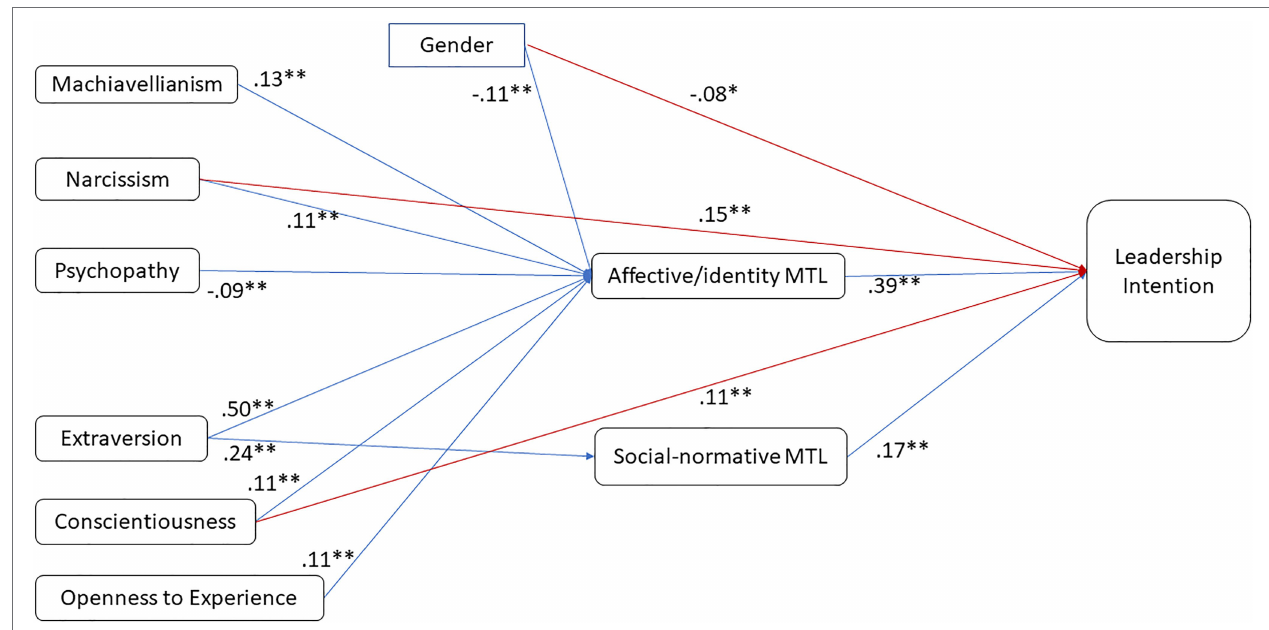
FIGURE 1 | Mediation model showing significant direct and indirect paths. * p < 0.05; ** p < 0.001. Only direct paths or paths that contribute to significant indirect effects (at 0.01 level) are